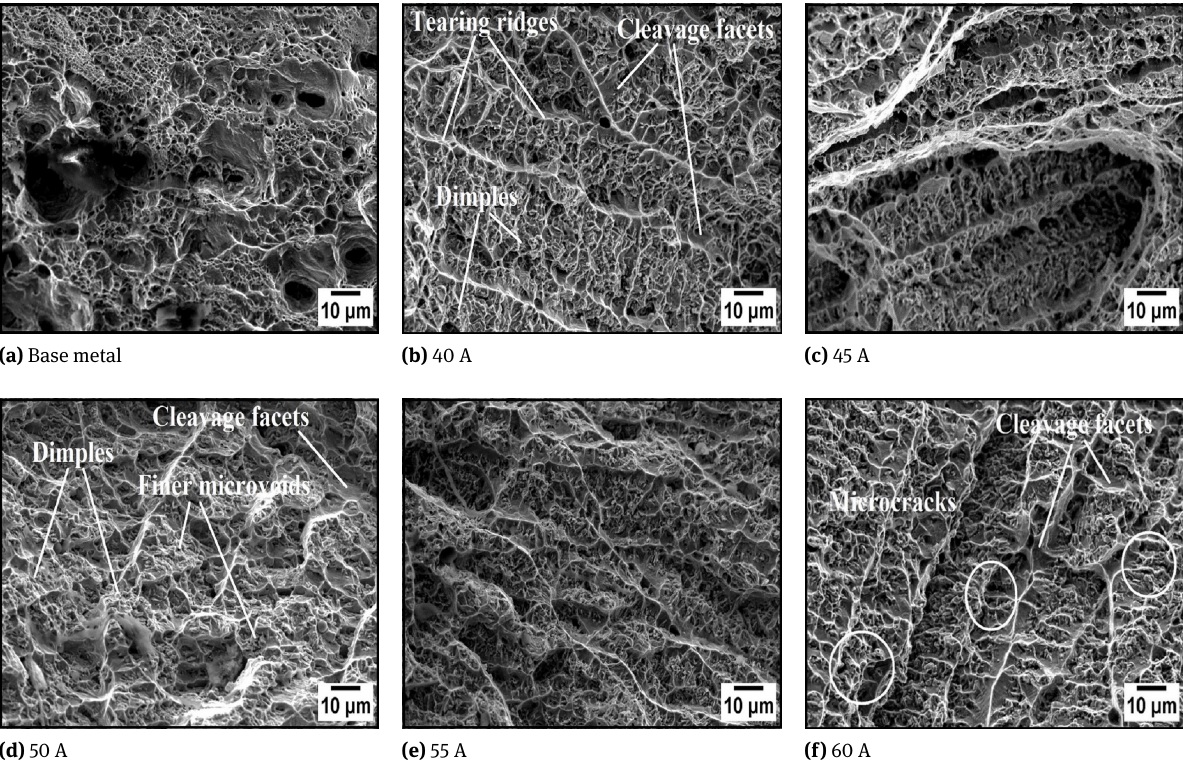
Figure 8: SEM fractograph of tensile specimens at different levels of Delta Current